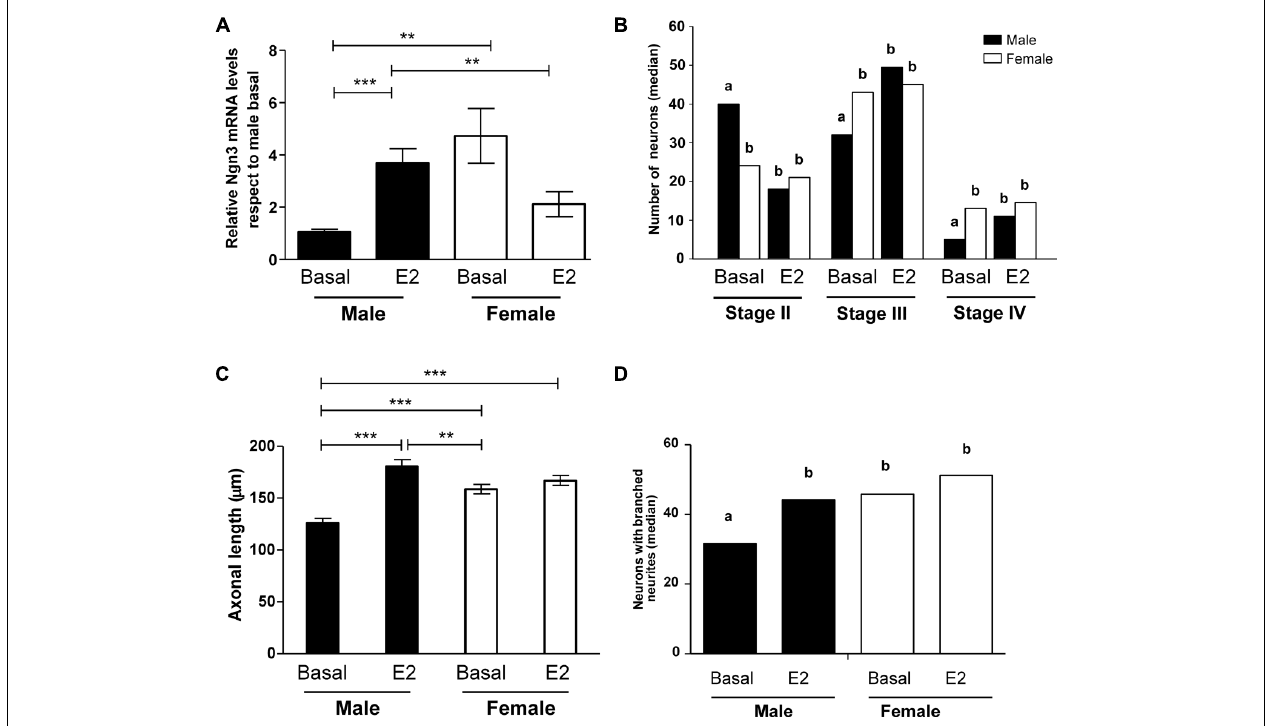
FIGURE 6 | Effect of 17 β -estradiol on Ngn3 mRNA levels and on parameters of neuronal morphology after 4 DIV. (A) Ngn3 mRNA levels. (B) Number of primary hypothalamic neurons at different stages of development. (C) Mean of axonal length. (D) Median number of neurons